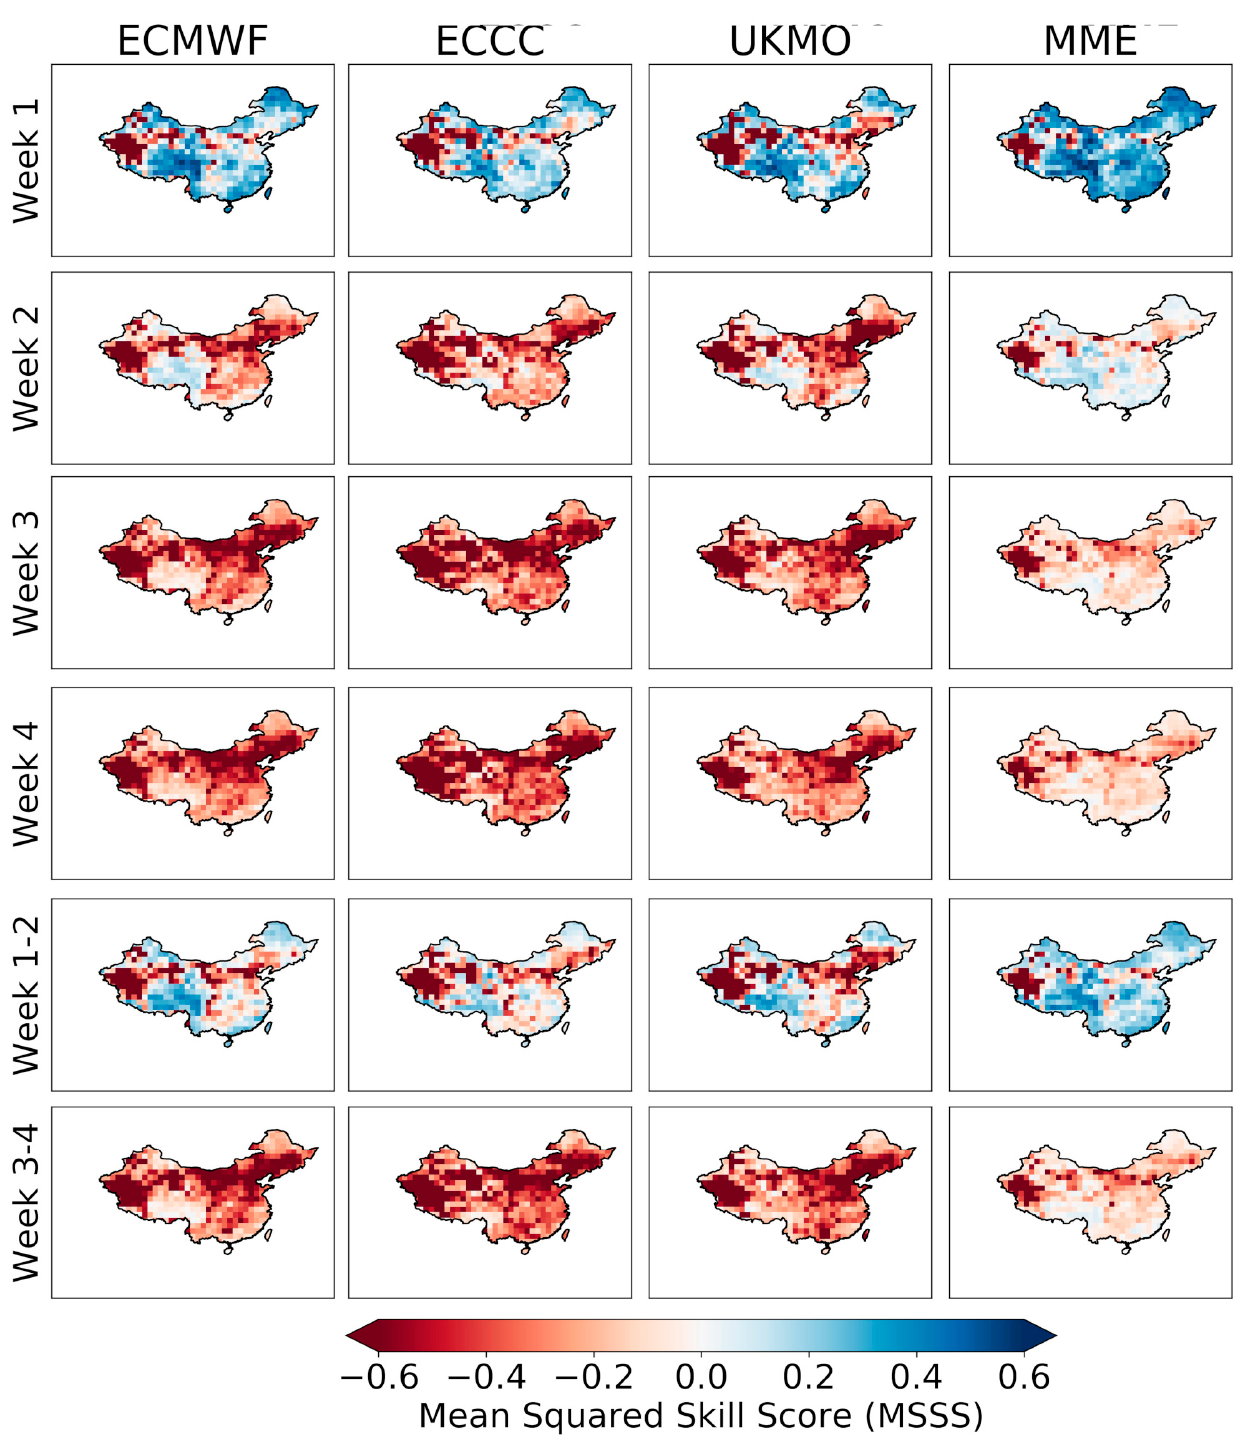
Figure 4. Mean squared skill score of week 1, week 2, week 3, week 4, week 1–2, and week 3–4 forecasts of the ECMWF model, the ECCC model, the UKMO model, and the MME model over China during the boreal summer monsoon.